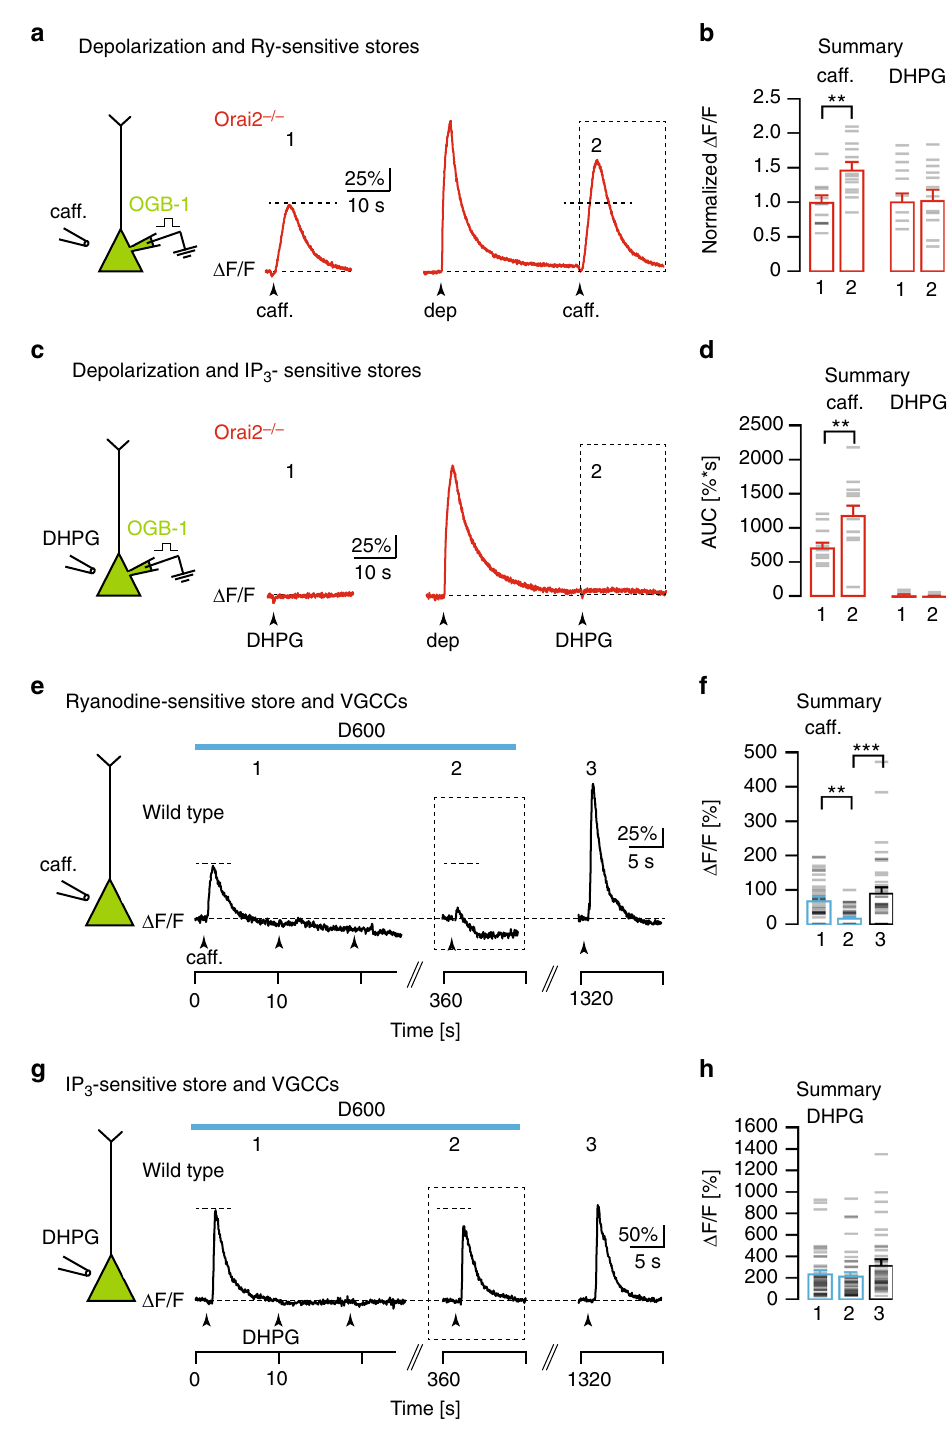
Methods Mice . All experimental procedures were in compliance with institutional animal welfare guidelines and were approved by the state government of Bavaria, Ger- many. Mice were maintained in an animal facility under a 12-h light/dark cycle and food and water was provided ad libitum. All the animal experiments were per- formed in accordance with the policies established by institutional animal welfare guidelines of the government of Bavaria, Germany. Orai1 loxP / − and Orai1 CA1KO/ − mice were generated by breeding mice with loxP - fl anked exons 2 and 3 in the Orai1 gene 32 to mice with a heterozygous expression of Cre under the control of the α CaMKII-promoter (T29-1) 33 . Cre/loxP recombination in the resulting offspring generates two types of genotypes: a CA1-PN-speci fi c (CA1KO) 33 or a general deletion ( − ) of the Orai1 gene (own fi nding). In the latter mouse line, we